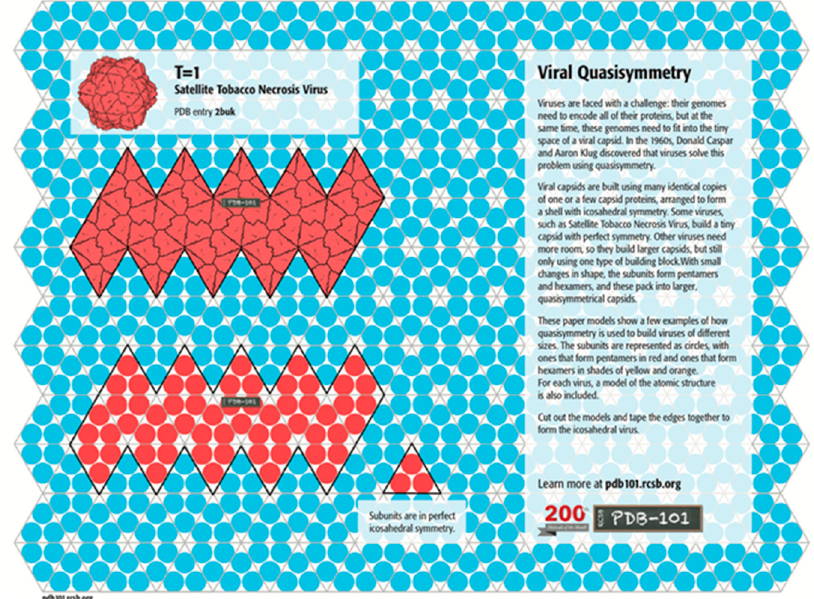
Figure 1. Dürer net of a Satellite Tobacco Necrosis Virus which has sixty capsomere protein subunits (3 per equilateral triangle). Source: CC By 4.0 license PDB-101 https://pdb101.rcsb.org/learn/paper- models/quasisymmetry-in-icosahedral-viruses (accessed on 1 December 2022).